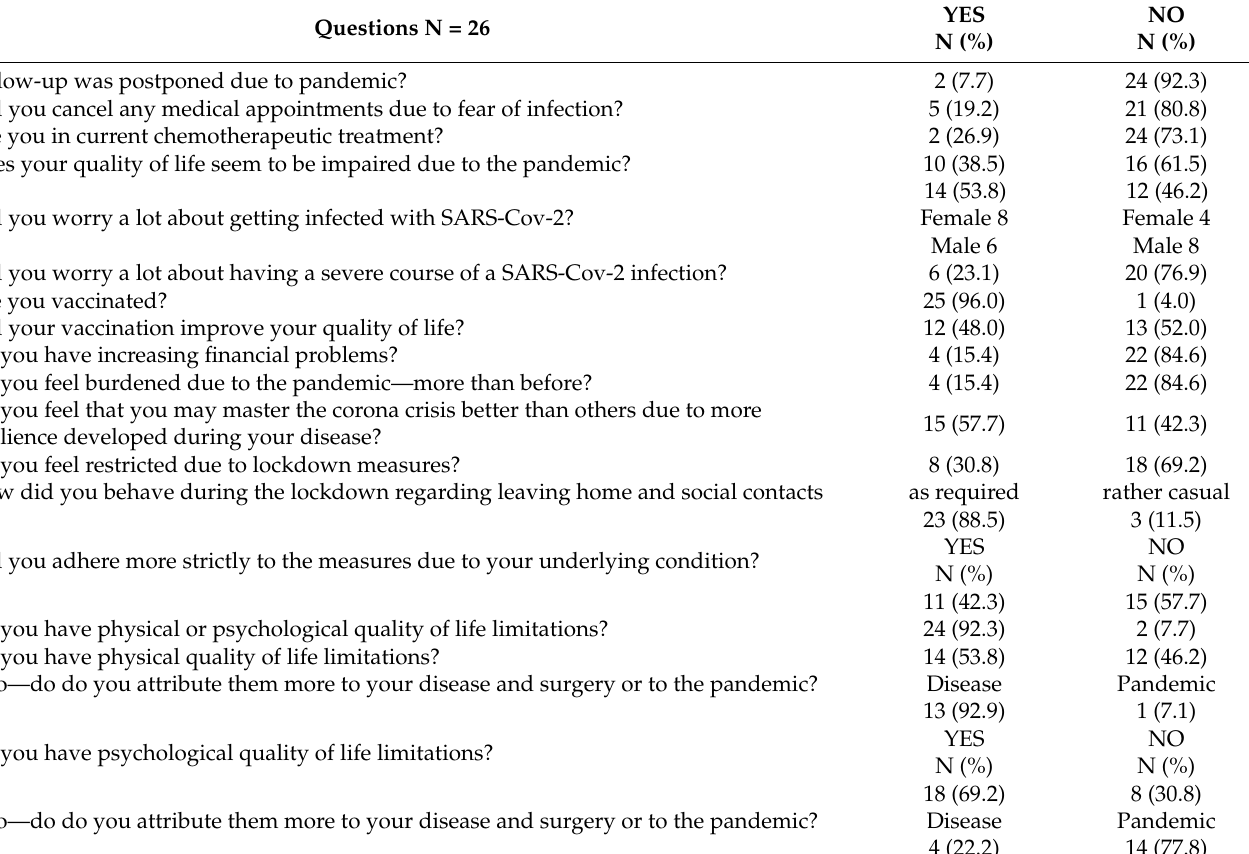
Table 2. Self-developed Questionnaire. Management of the COVID-19 pandemic in a sample of pancreatic cancer